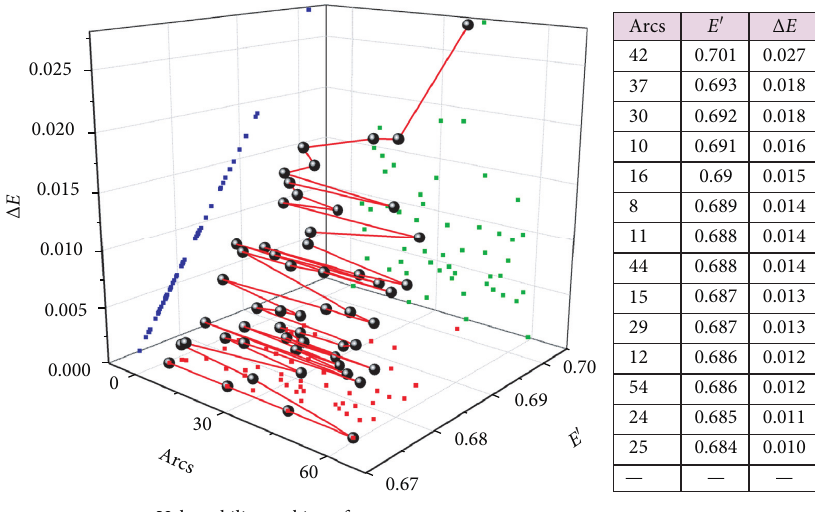
Figure 6: Road network vulnerability identification based on efficiency.